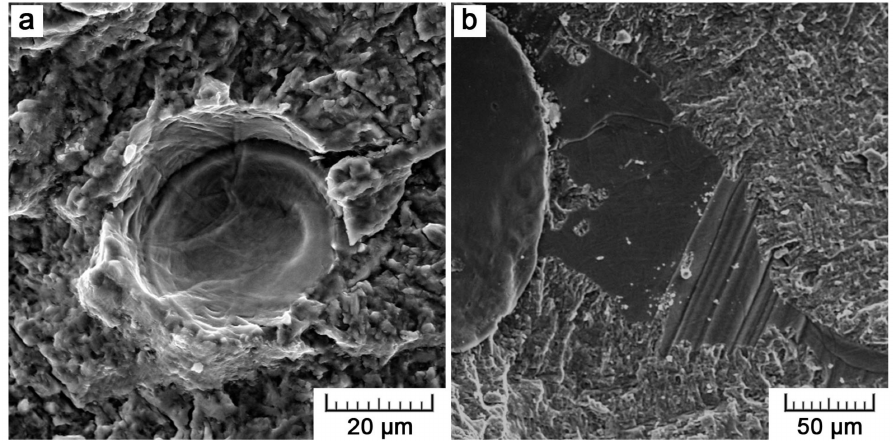
Figure 9. Defects observed in the fatigue crack propagation area of EBM specimen: ( a ) gas bubbles and ( b )